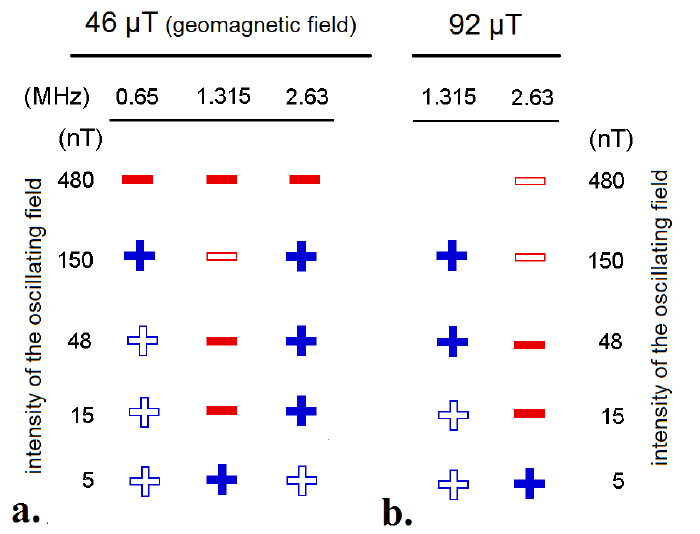
Figure 7. Summary of the tests with different frequencies and different intensities: ( a ) in the geomagnetic field of 46 μT and ( b ) in a 92 μT field, twice that intensity. Red: −, disoriented behavior, indicating an interference with magnetoreception; blue: + no disruptive effect of the respective oscillating field. Solid symbols: results from experiments, open symbols: inferred from the other results under the assumption of monotony (based on data from